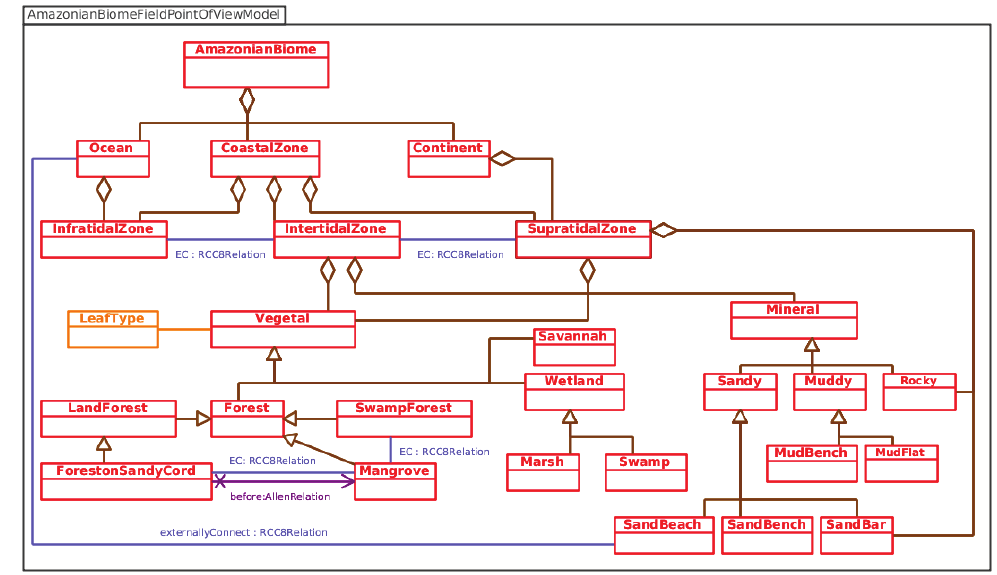
Figure 12: Field point-of-view